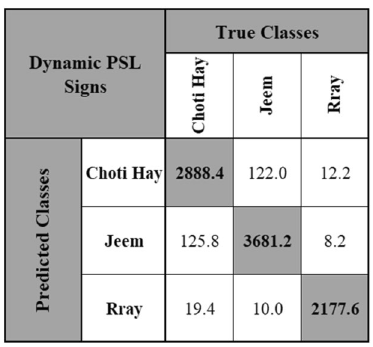
Figure 8. Confusion matrix of dynamic PSL signs at 480 × 270 video resolution and 200 bags.